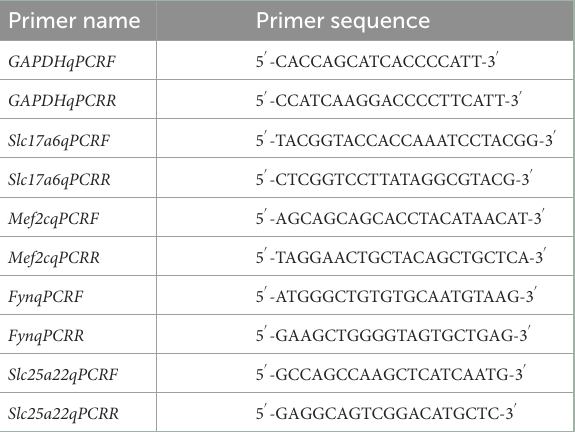
TABLE 1 Primers for quantitative real-time PCR.